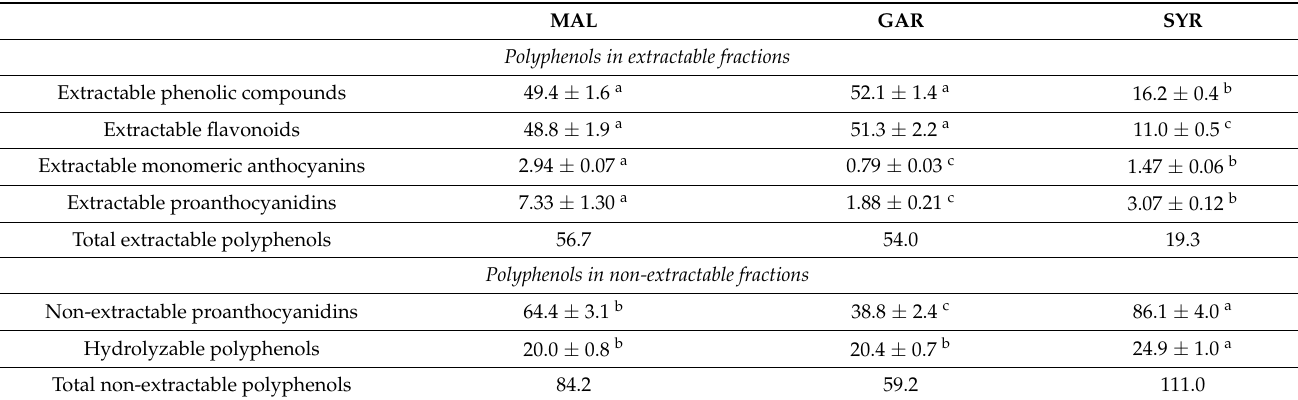
Table 1. Extractable and non-extractable polyphenol content of different varieties of grape pomace. MAL